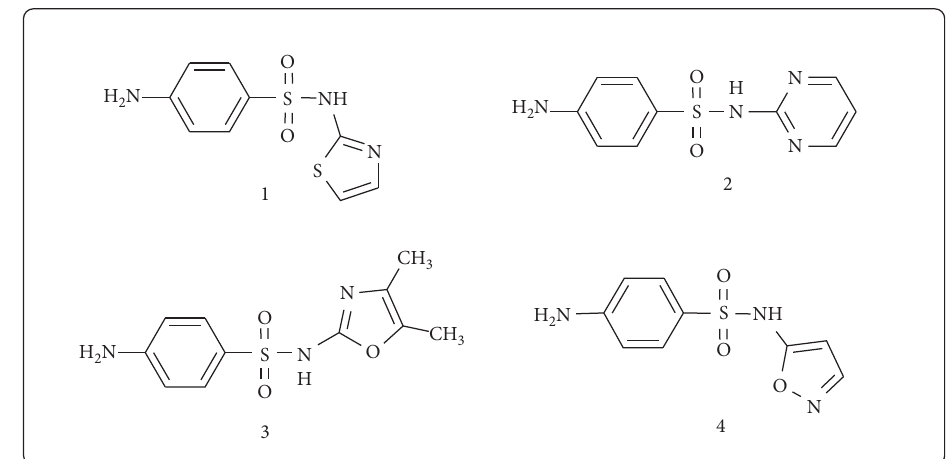
Figure 1: Chemical structure of few drugs containing sulfathiazole scaffold.